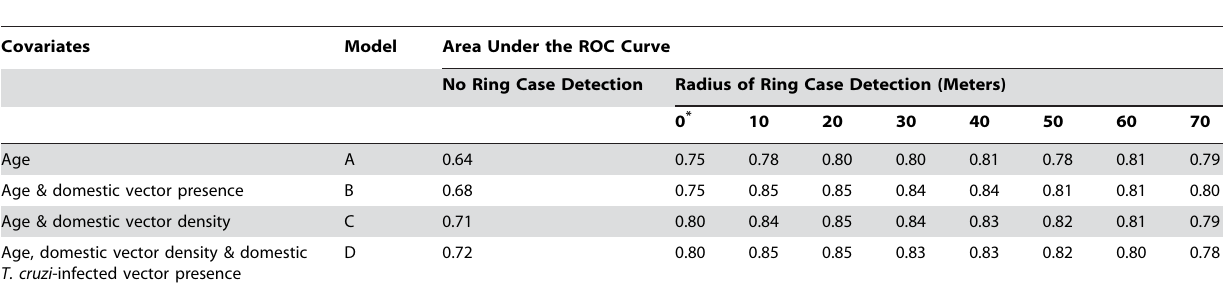
Table 3. Area under the curve for multivariate models predicting T. cruzi infection in children aged 18 years and younger in the community of Guadalupe, Arequipa, Peru,